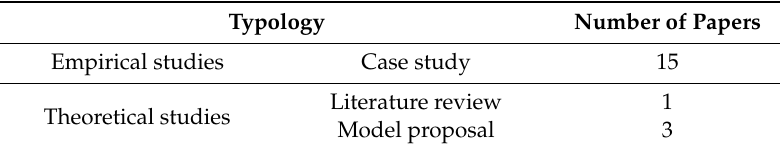
Table 5. Typology of the